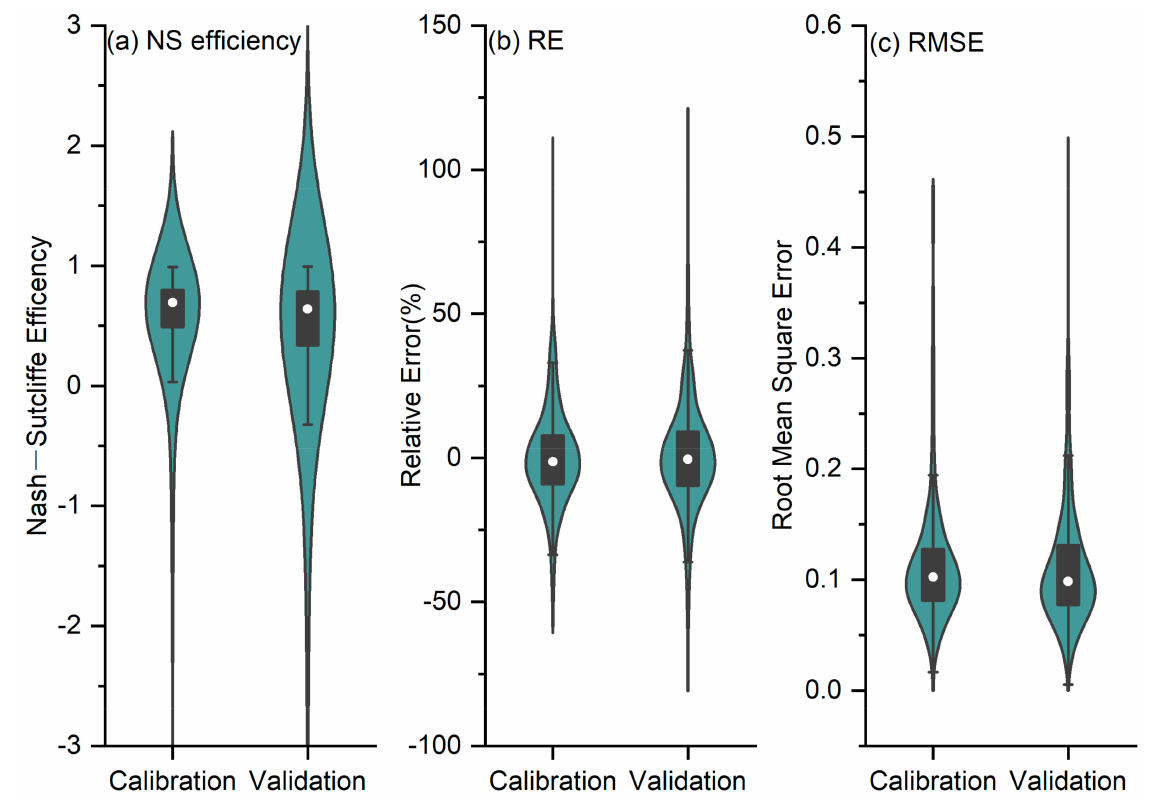
Figure 4. Overall performance metrics of the EF model used for each 10 km grid in calibration and validation period,